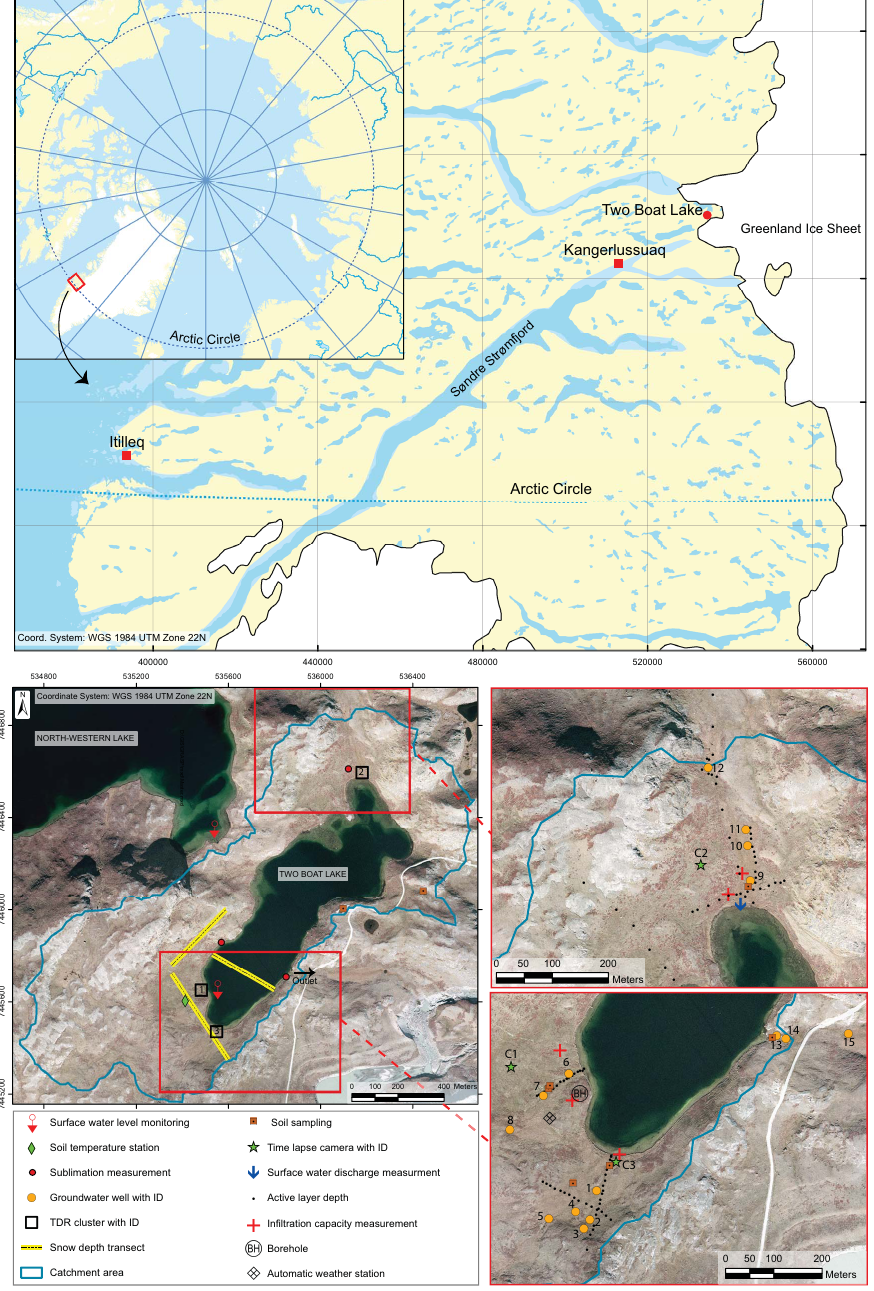
Figure 1. The regional area of Kangerlussuaq and the TBL catchment, installations, and sampling